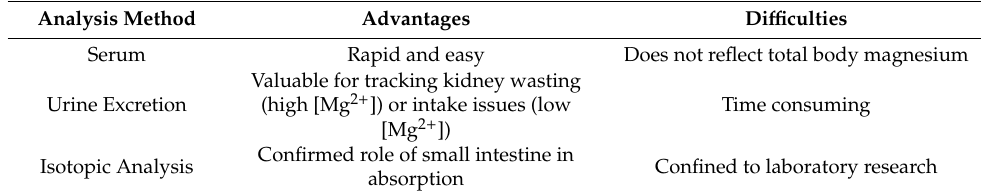
Table 2. Common methods used for the determination of magnesium status with pros and